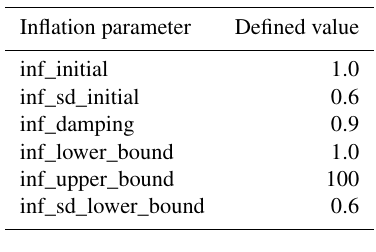
Table 3. The surface types used to generate the initial ensemble of forecasts. Lu0 is the initial land use index in the CM1